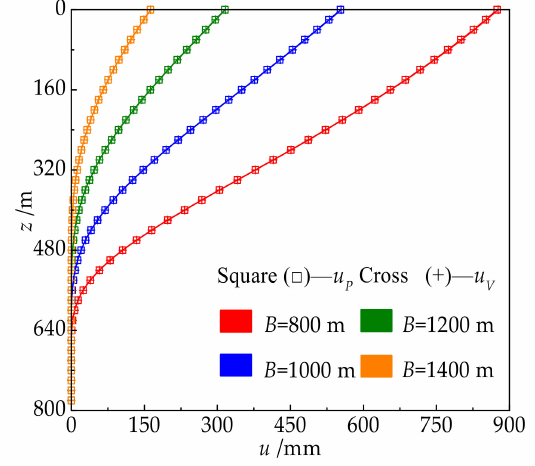
Figure 10. The shaft horizontal displacement curve ( n =